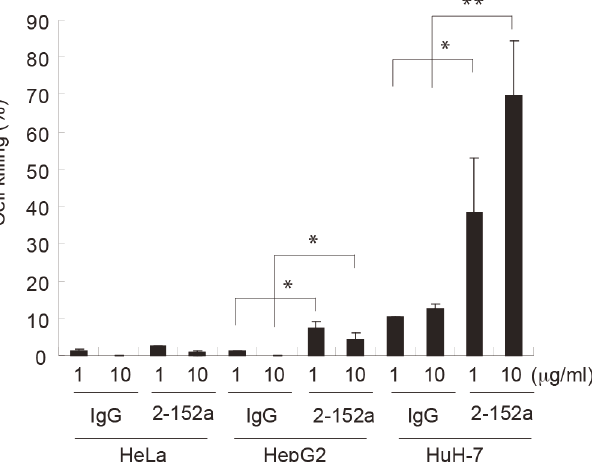
Fig 5. Complement-dependent cytotoxicity (CDC) induced by 2-152a MAb. HeLa, HepG2, and HuH-7 cells (1 × 10 6 ) were incubated with 2-152a MAb or mouse IgG (final concentration, 1 or 10 μ g/mL) in the presence of guinea pig complement (the complement:cell ratio was 1:8 for HeLa and HepG2 and 1:20 for HuH-7) for 30 minutes at 30°C. Cell viability was measured using the WST-8 cell counting kit, and cell killing was calculated by comparing death in the experimentally treated cells with that in the untreated cells. * , p < 0.05; ** , p <